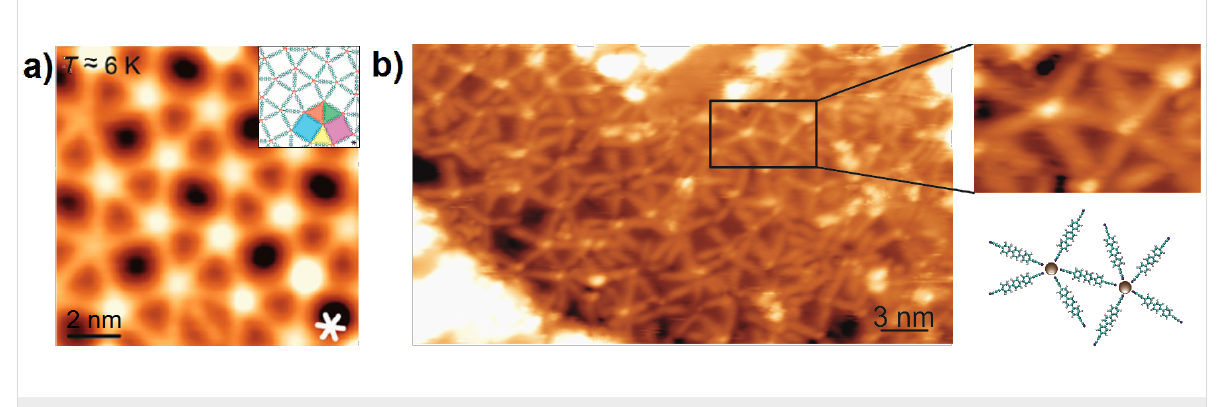
Figure 5: STM image of the lanthanide-directed assembly on Ag(111) for appreciable surface concentration (linker: Ln = 5:2). a) Snub square tiling motif comprised of NC–Ph 3 –CN ( 1 ) linkers and Gd centers (atomistic model of the snub square Archimedean tessellation of the surface in insert), reprinted with permission from [21], copyright 2014 American Chemical Society; b) irregular metal–organic network comprised of NC–C ≡ C–Ph 3 –C ≡ C–CN ( 2 ) molecules and Gd centers. In inset: model of one of the coordination units presented (the 5-fold linker Gd nonameric unit. Data was obtained at 6 K. Image size: 352 × 195 Å 2 . Scanning parameters: V bias = 0.7 V, I = 0.1